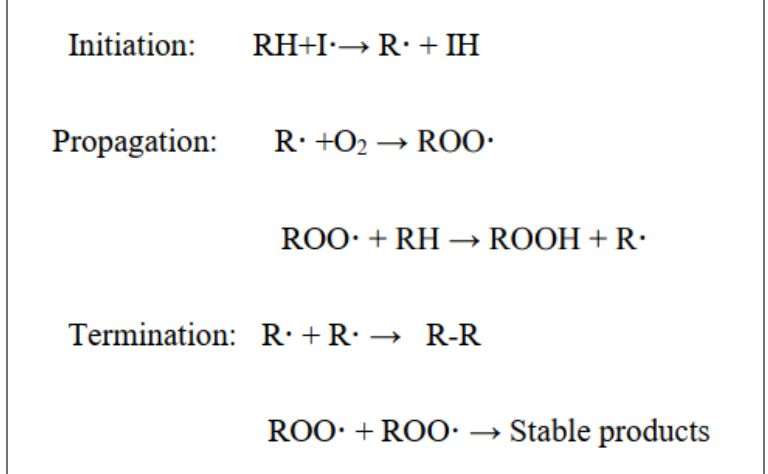
Figure 1. Oxidation chain reaction for hydroperoxide formation.